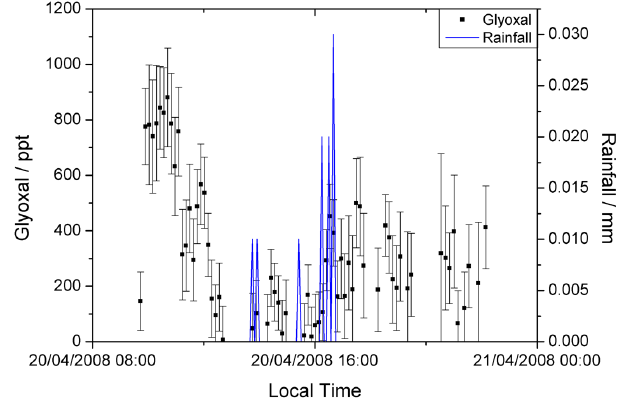
Fig. 9. LP-DOAS measurements of glyoxal (black squares) on 20 April 2008 showing a sharp drop in the middle of the day dur- ing an episode of rainfall measured at the GAW tower (blue lines). Missing data points are due to poor visibility for DOAS measure- ments caused by the rainfall. Note that because of the localised na- ture of the showers, the anti-correlation is not